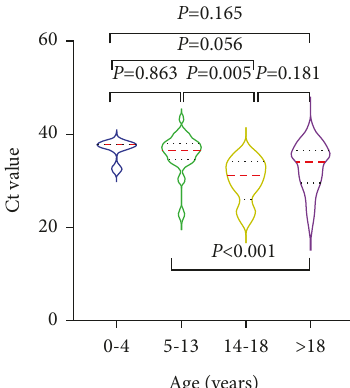
Figure 3: Ct values of oropharyngeal nucleic acid tests in symp- tomatic patients stratified by age.